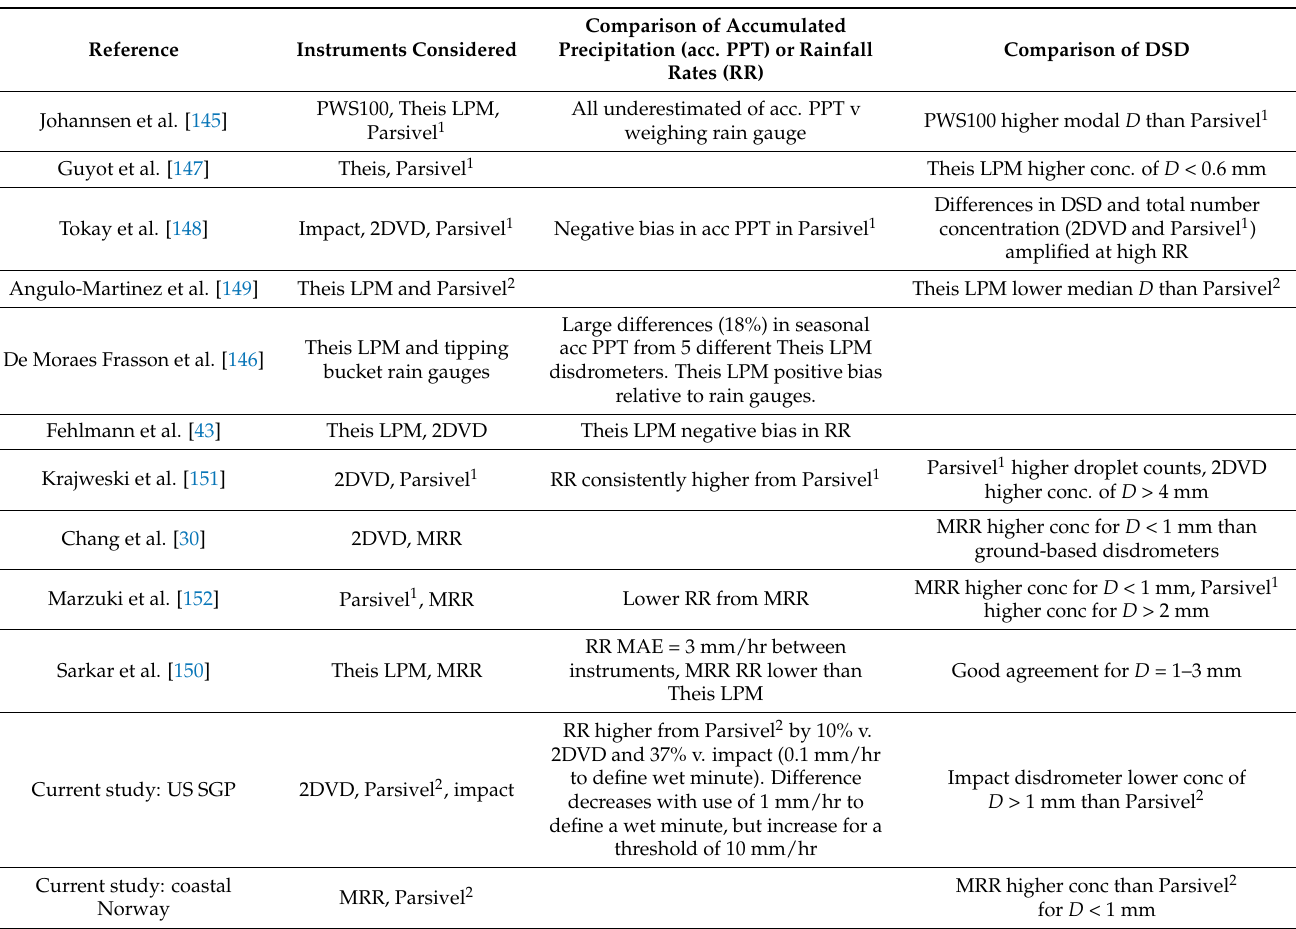
Table 3. Summary of some previous closure experiments for different disdrometers, and new findings from the current